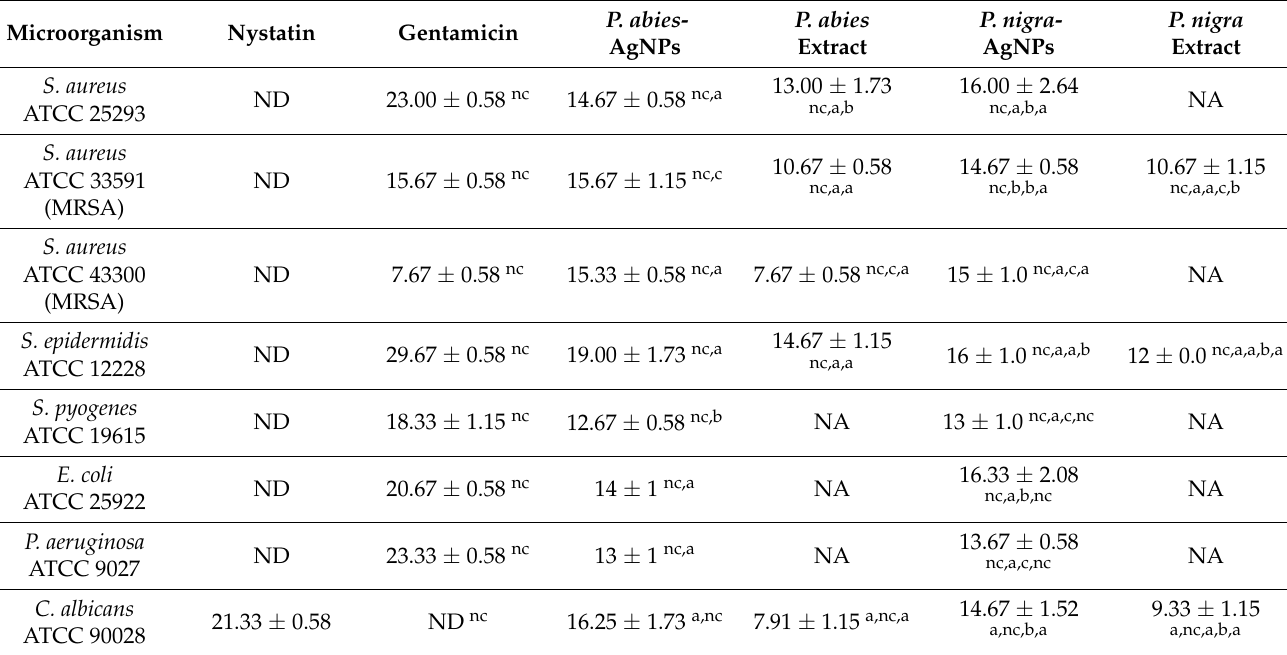
Table 2. Diameters of inhibition zones (mm) developed by AgNPs and bark extracts used for their synthesis against pathogenic bacteria and